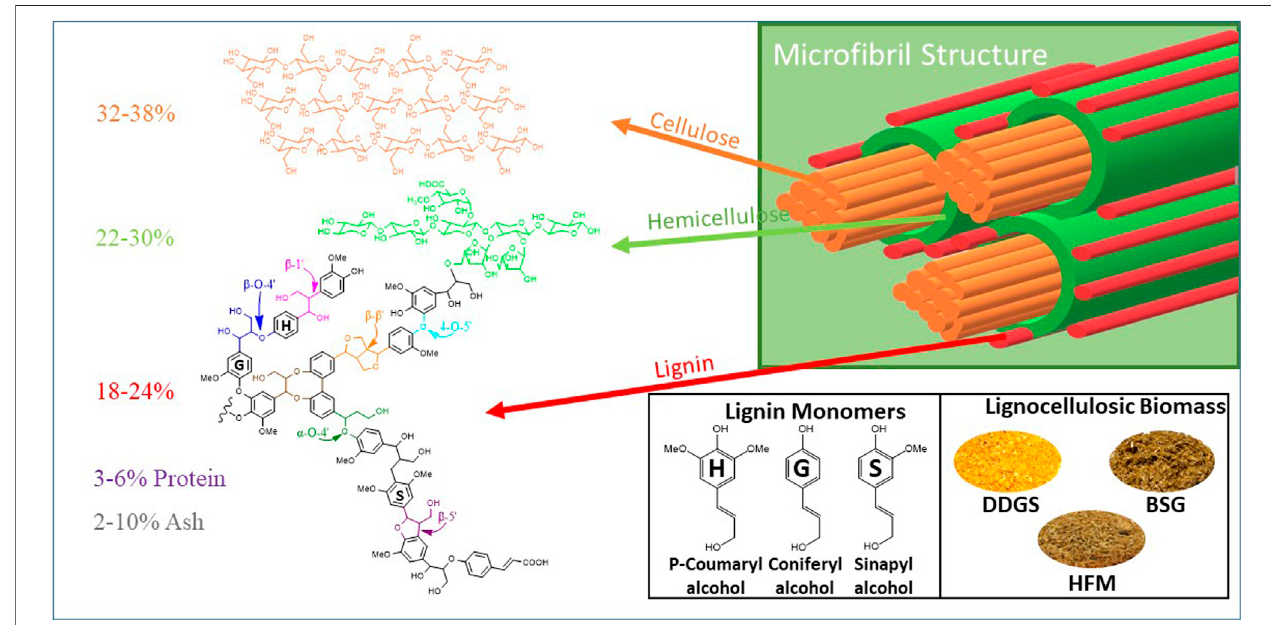
FIGURE 1 | Ultrastructure of plant cell wall comprising cellulose, hemicellulose, lignin, protein, and ash in different ratios. Detailed structure of lignin monomers. Three different types of lignocellulosic biomass, namely, dry distillers grains with soluble (DDGS), high- fi ber meal (HFM), and Brewer ’ s spent grains (BSG), used to produce de-esteri fi ed biomass without carboxamides are